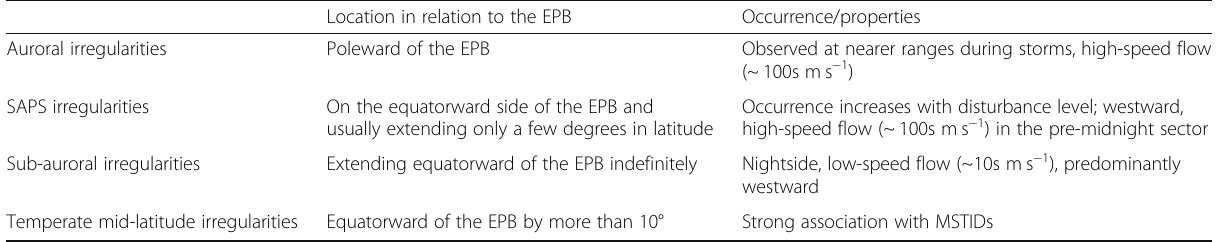
Table 2 Categories of mid-latitude irregularities with respect to the Equatorward Precipitation Boundary (EPB) Location in relation to the EPB Auroral